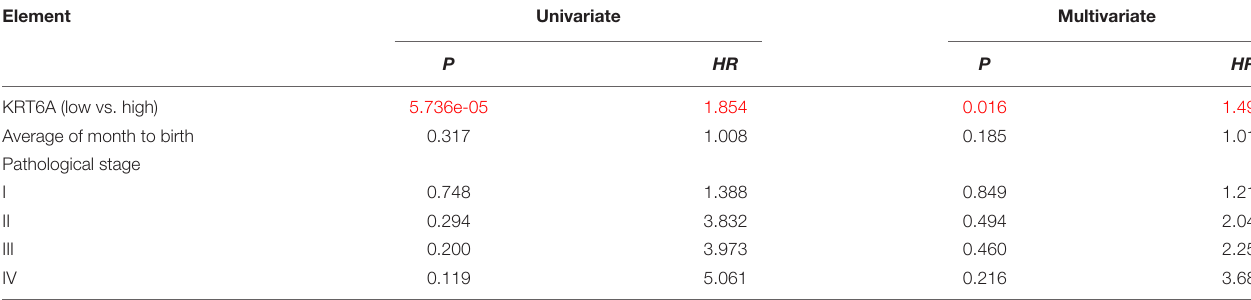
TABLE 3 | Cox regression analysis of risk factors for cancer related death in NSCLC patients.